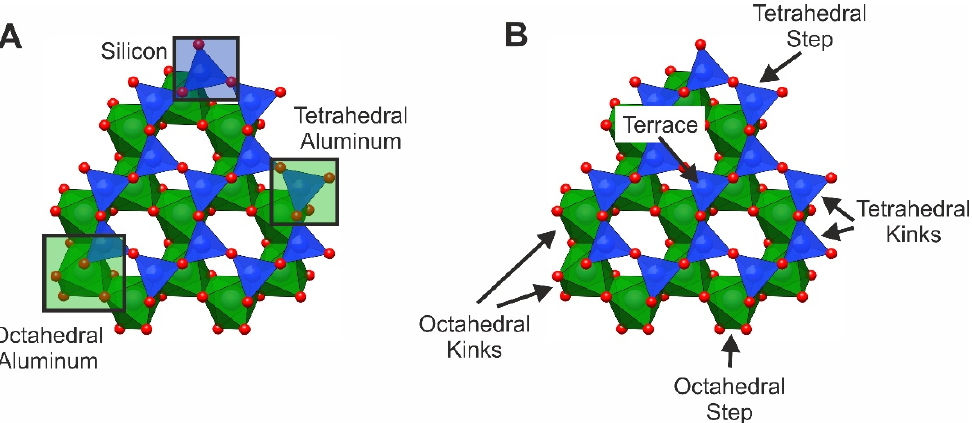
Figure 5. Surface sites on the muscovite (001) basal plane. ( A ) The current variability of adsorption sites differentiating between the available cations and their oxygen coordination resulting in three different possibilities. Exemplary sites are highlighted, but no difference exists to non-highlighted surface atoms regarding the adsorption affinity. ( B ) Surface sites characterized by their coordination environment. Considering the coordination results in higher complexity of possible adsorption sites. Note that for a precise description of kink and step positions, more information on coordination beyond the size of this sketch is required and that no terrace positions for the octahedral layer occur in muscovite. Another level of complexity can be added when considering step orientation and upper/lower layer differences. For a more detailed depiction of muscovite surface sites see Figure 10 in [5].